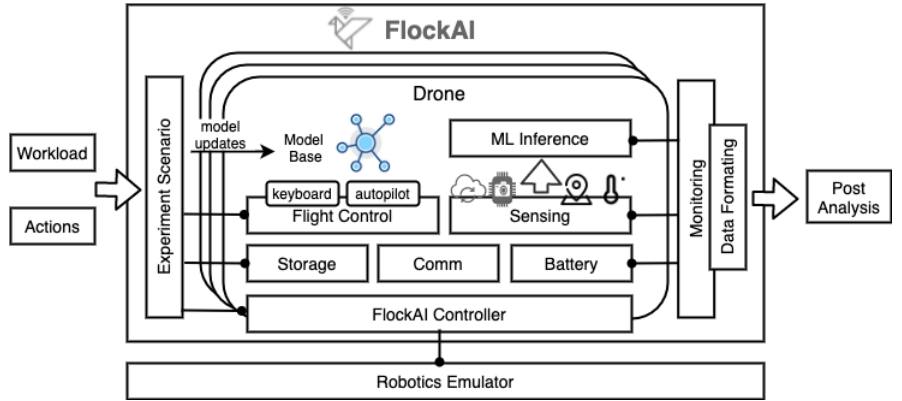
Figure 2. High-level and abstract overview of